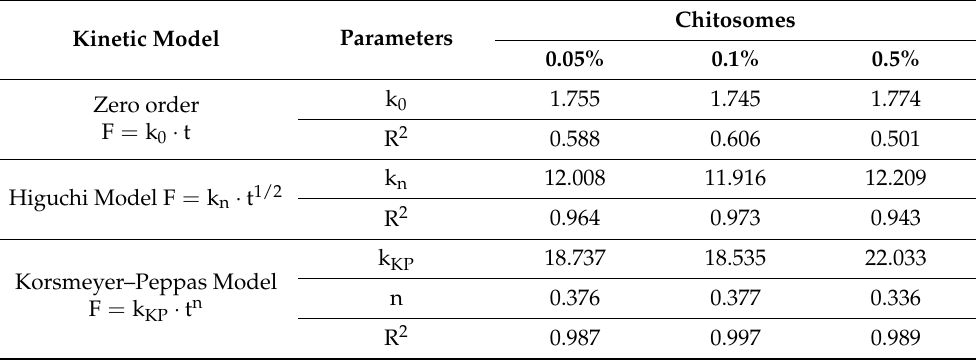
Table 4. Kinetic models of 2-PAM release from chitosomes in vitro .